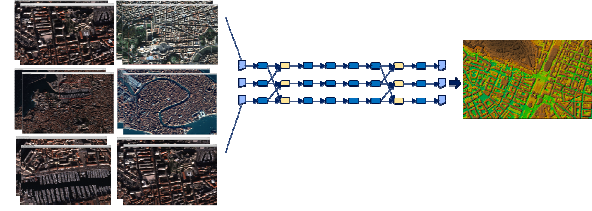
Figure 4: Paradigm for Spark parallelization.